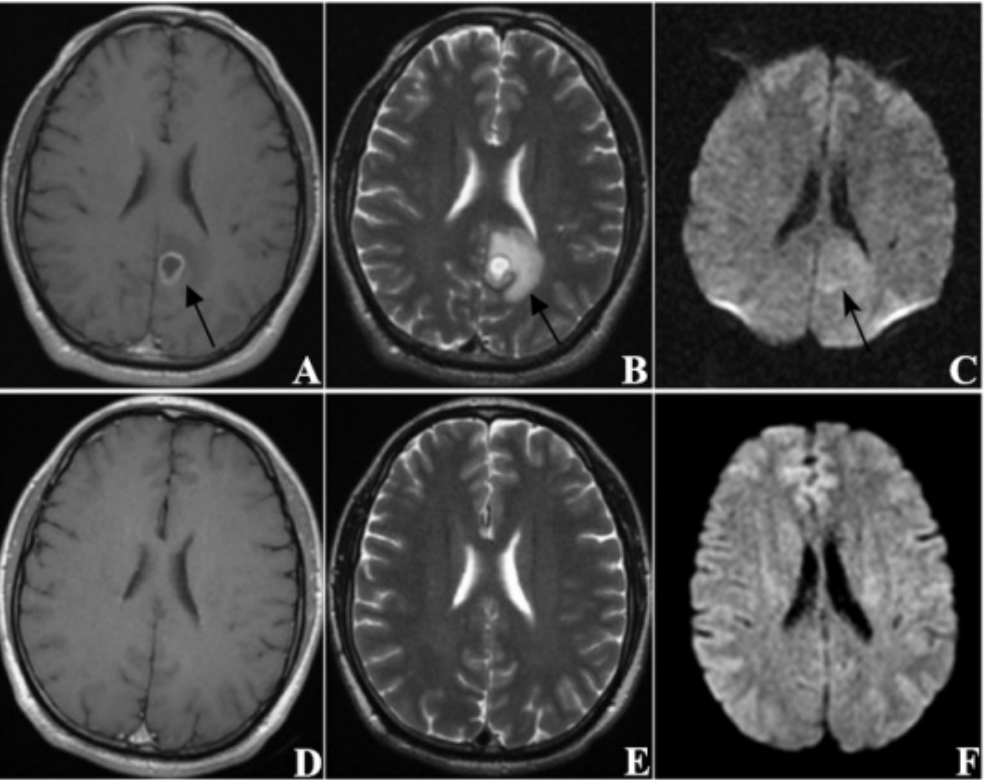
Figure 4. A sixty-three-year-old male patient (KPS = 80) with brain metastases ( n = 1) from lung cancer. The primary tumor had been completely removed without recurrence and no extracranial metastasis was found. ( A – C ) are MRI images taken before SRS treatment, and ( D – F ) are MRI images taken at follow-up 63 days after treatment (( A , D ) from CE-T1WI; ( B , E ) from T2WI; ( C , F ) from DWI). The tumor was located in the left occipital lobe and showed ring-like enhancement. The EI was 3.55. After treatment, the tumor disappeared, thus this patient was classified as CR.